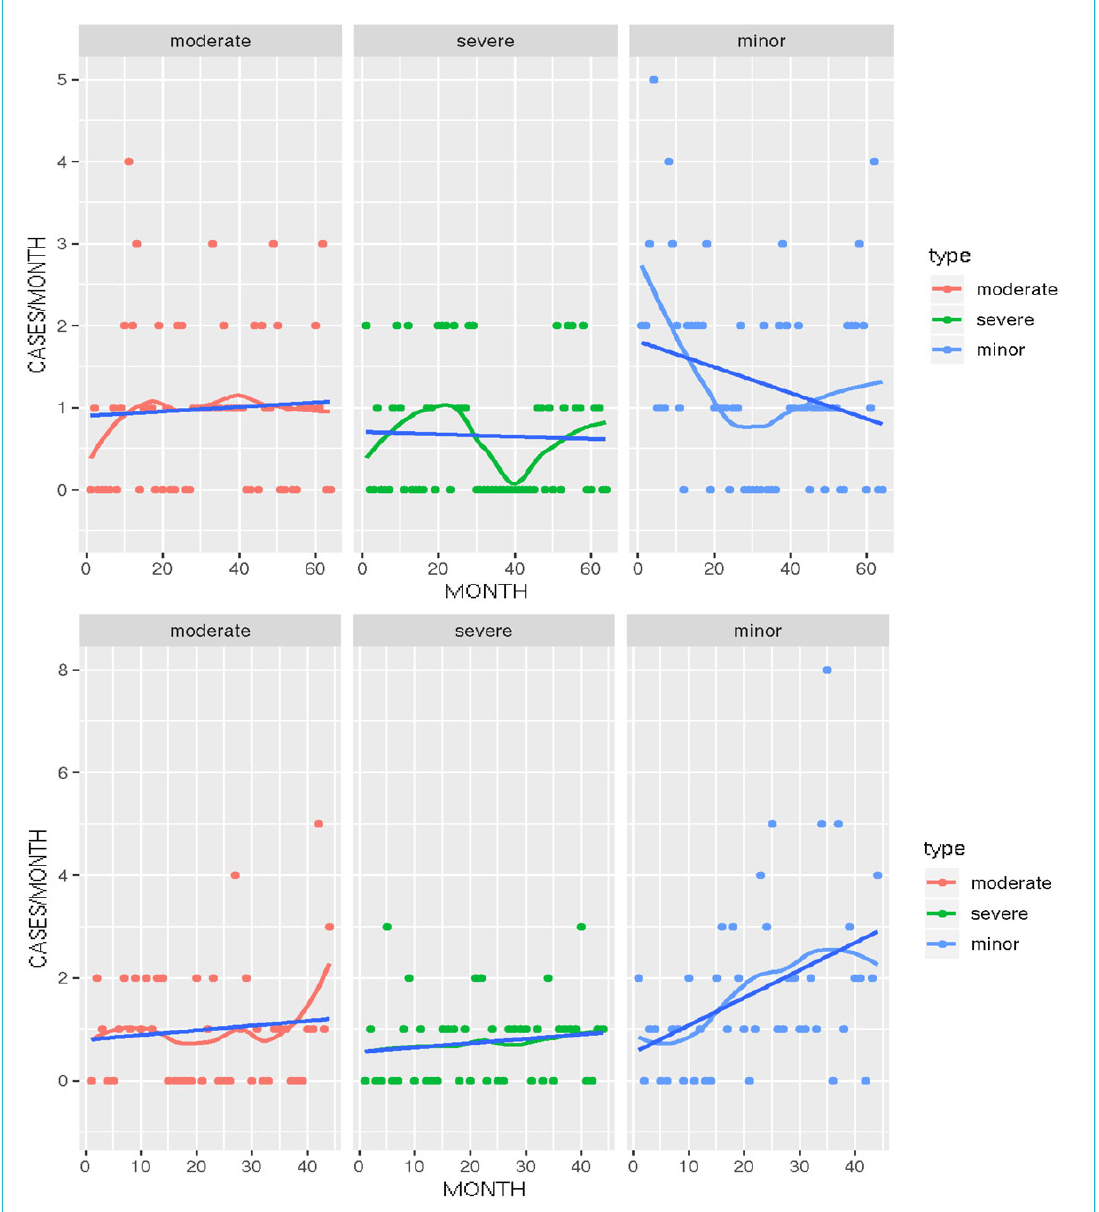
Figure S1: Trends in severity of toxicity in (a) Bern, (b) Basel. Red, green and light blue = lowess (locally weighted scatterplot smoothing) curve